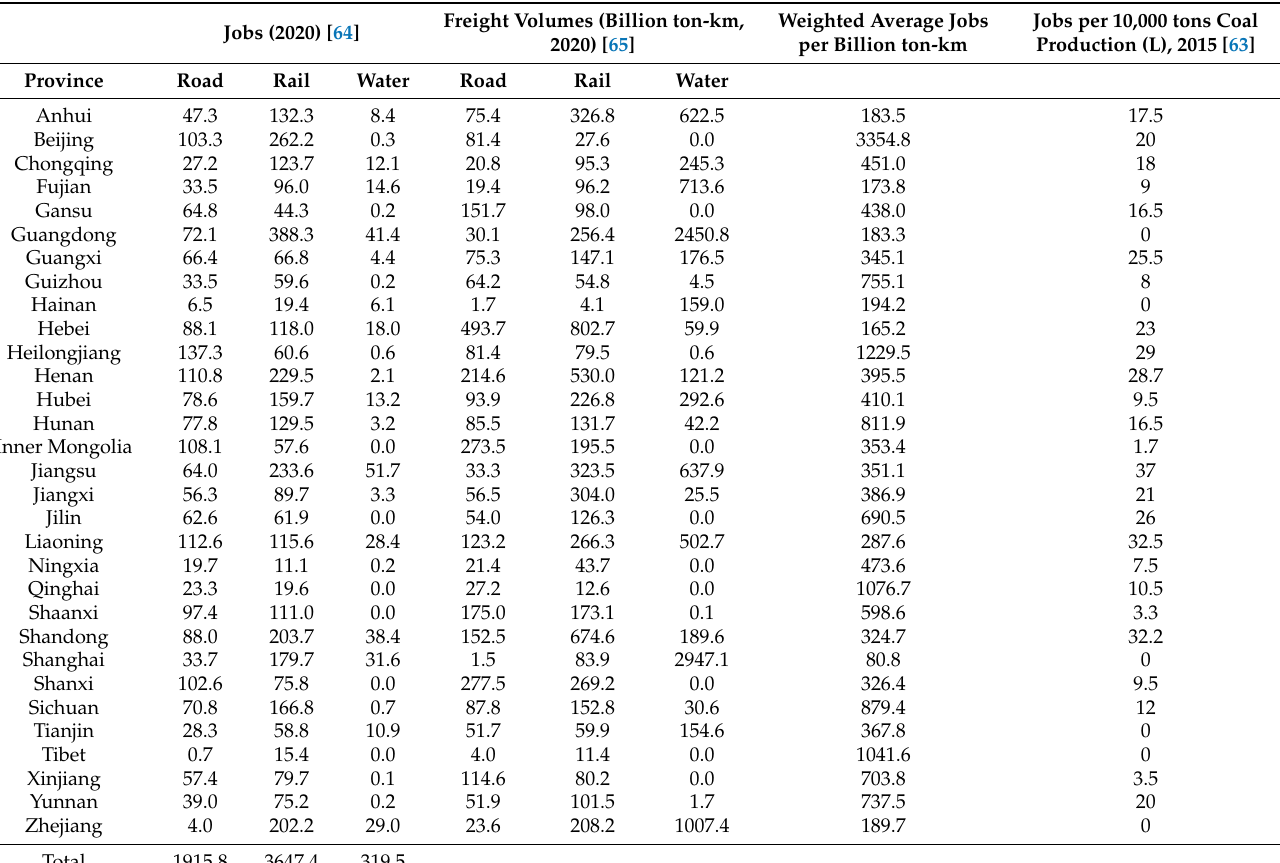
Table A11. Estimated jobs per billion ton-km of coal transported, and per 10,000 tons of coal produced, by